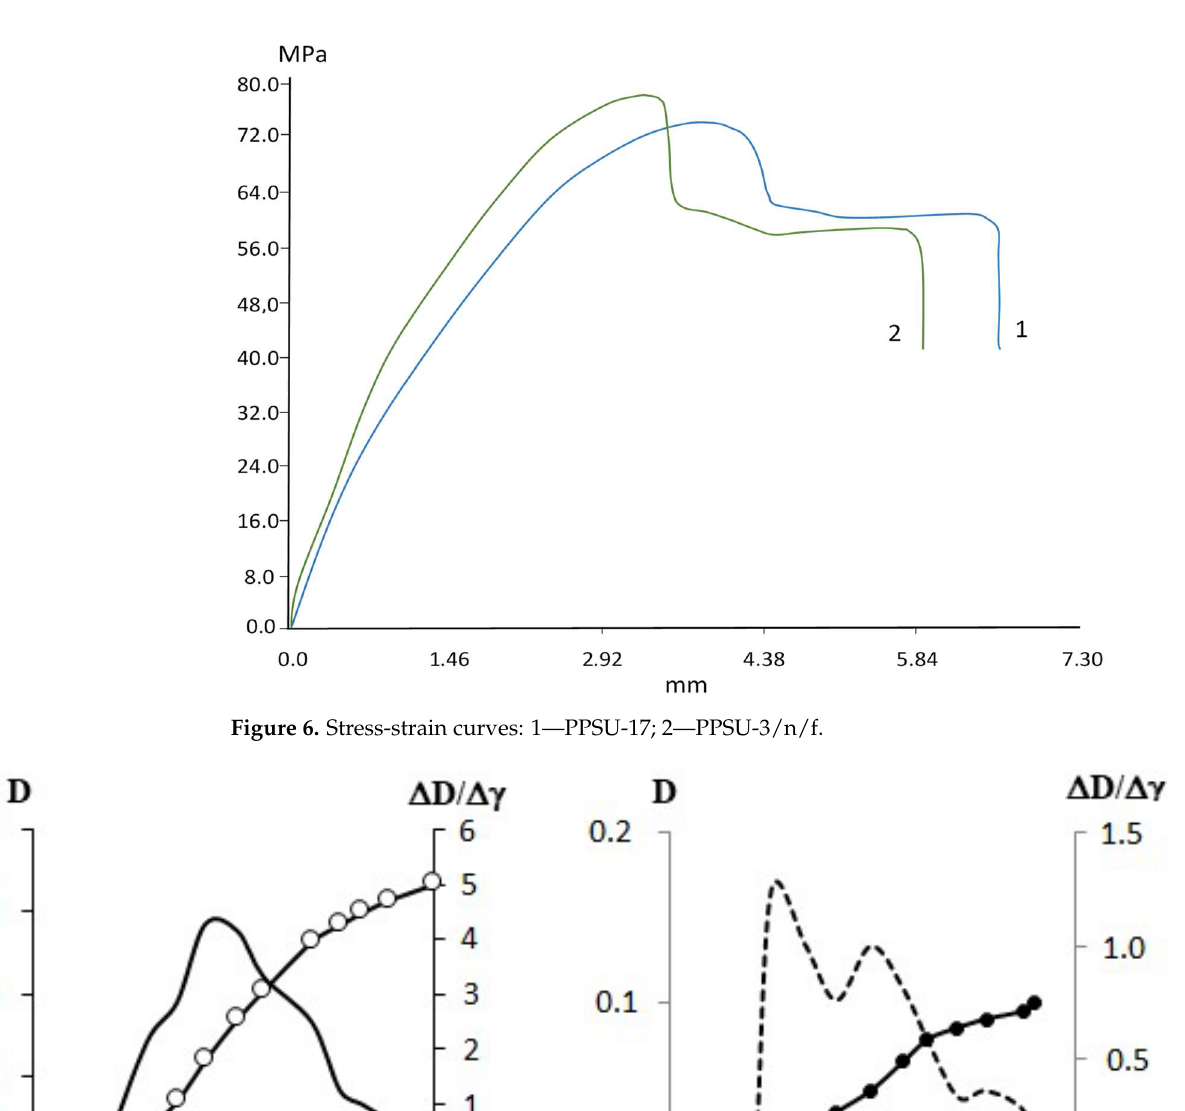
Figure 6. Stress-strain curves: 1—PPSU-17; 2—PPSU-3/n/f.